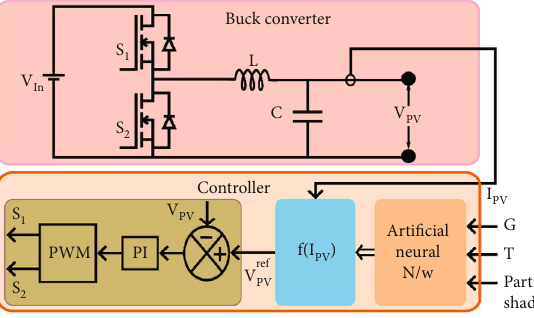
Figure 6: Block diagram of the proposed ANN-based